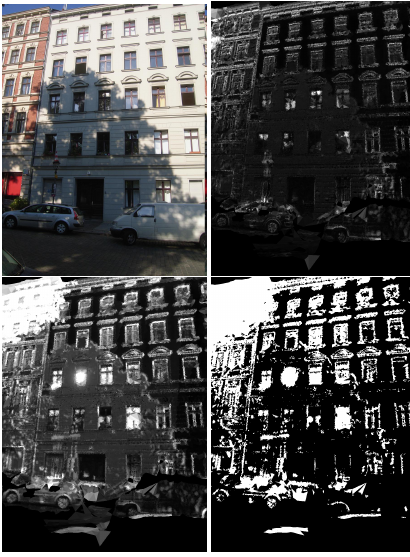
Figure 7. From top left to bottom right: fac¸ade image, visualiza- tion of colour differences to neighbouring images only, visualiza- tion of colour differences to complete sequence, segmentation of colour difference image using the 0 . 7 quantile of pixels unequal 0